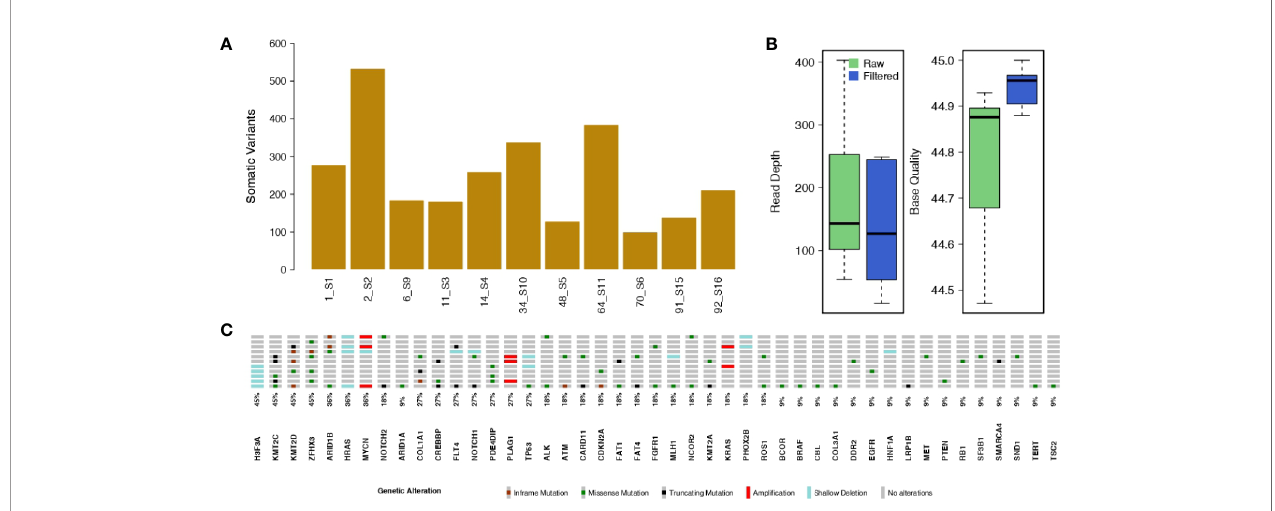
FIGURE 1 | Somatic single nucleotide variants and copy number alterations. (A) The bar plot shows the number of raw somatic variant calls. (B) Box plots showing the mean Read Depth and the mean Base Quality for raw variant calls and for the fi ltered somatic variants. (C) Oncoprint reporting the somatically altered genes along with their mutation frequency.